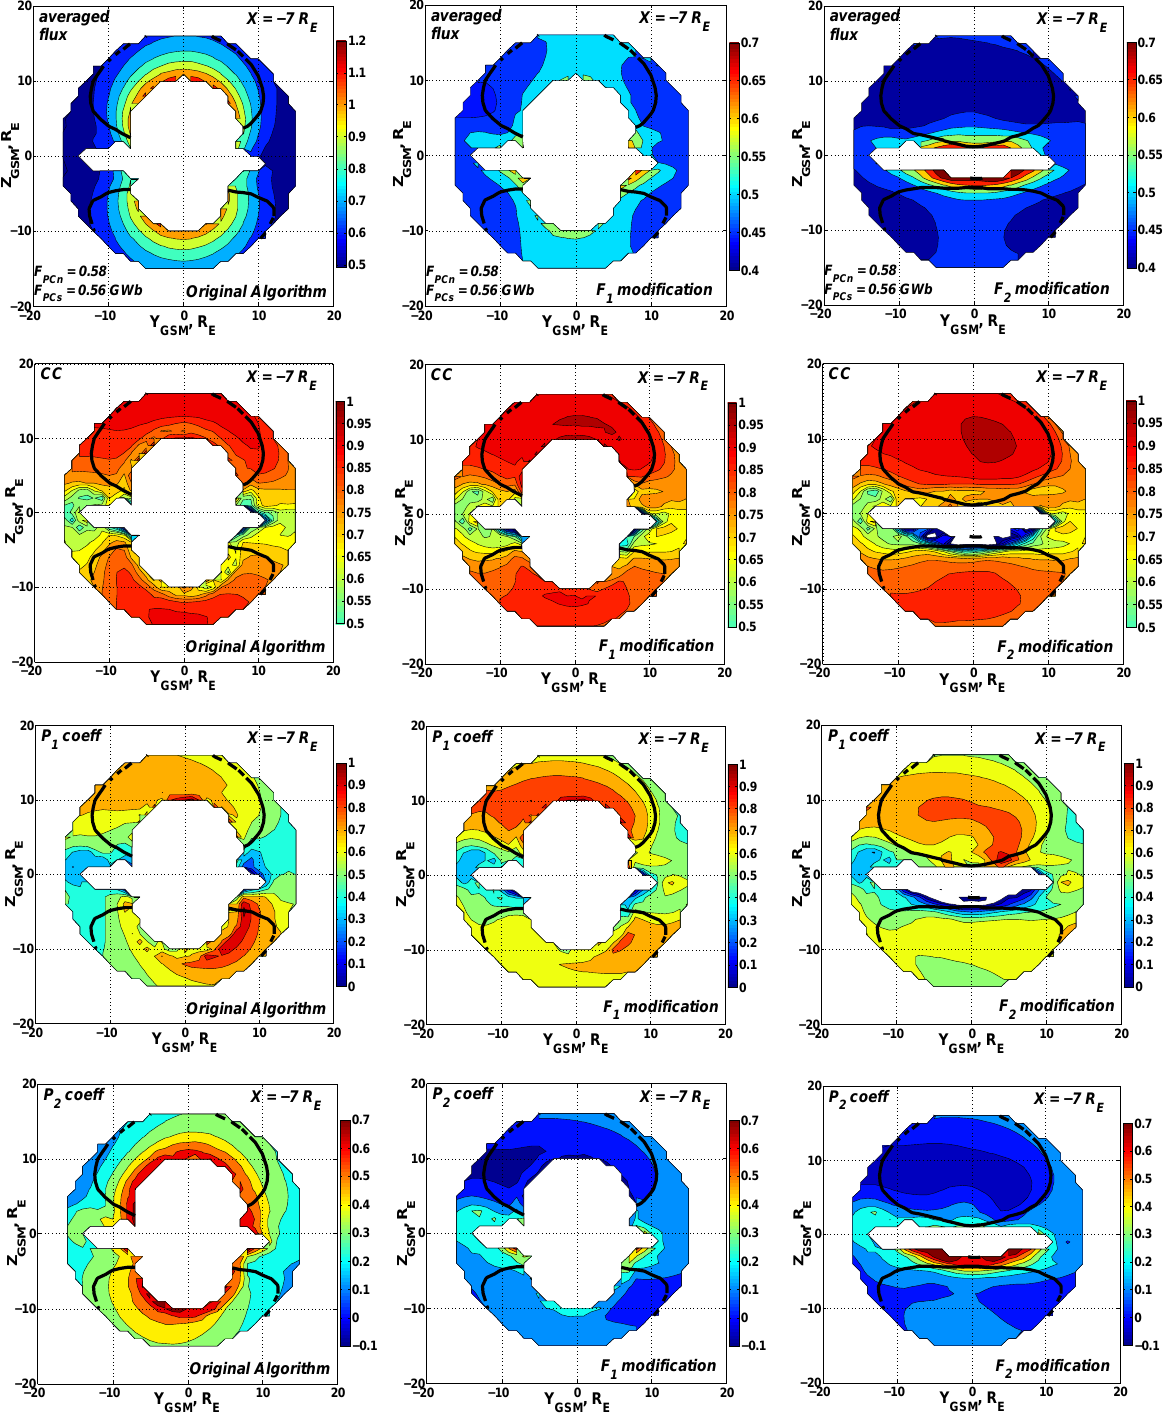
Figure 6. Real event simulation BATSRUS_Sergeev_060508_1. Distributions of the average over the simulation flux value, correlation and regression coefficients and the free term, describing the relationship of F T 0 , F T 1 and F T 2 , “measured” at x = − 7 R E , with the F MHD Black thick contour on each panel bounds the lobes with β < 1. Note the different color bar scale for the average values of F T 0 and F T 1 , F T 2 in the first